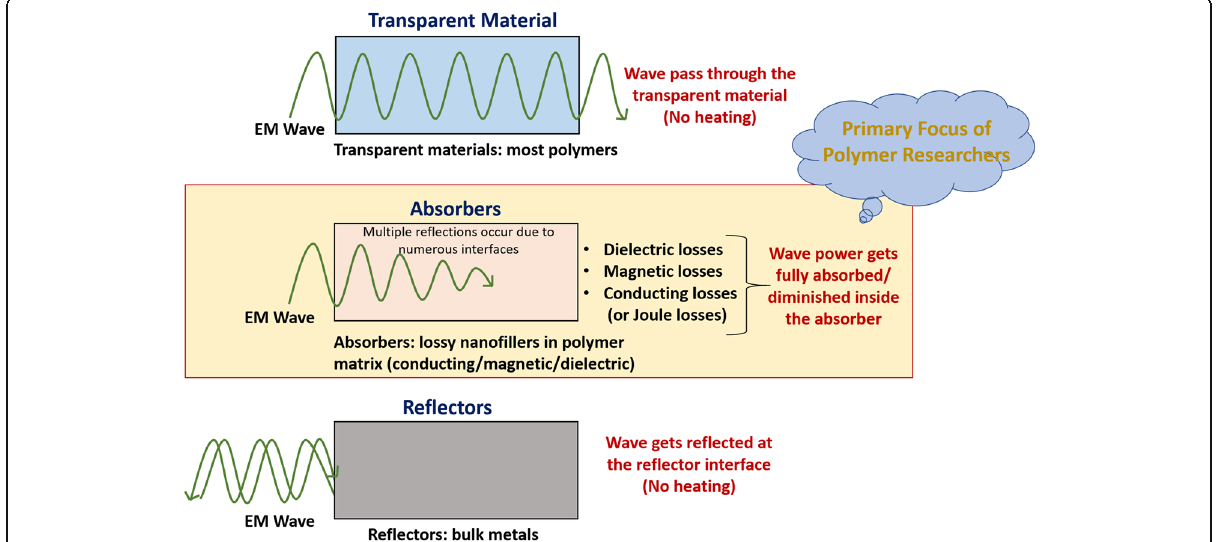
Fig. 4 Schematic representing the interaction of different types of materials with EM